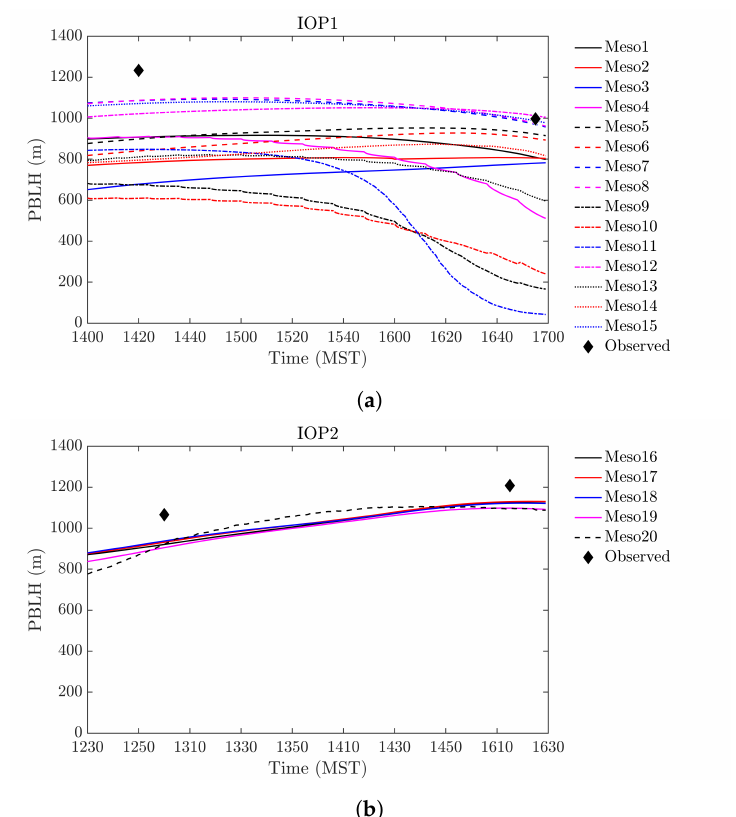
Figure 3. PBL height simulated by WRF mesoscale runs during: ( a ) IOP1; and ( b ) IOP2. The observed values correspond to the mixing heights estimated from the radiosonde launches during IOP1 and